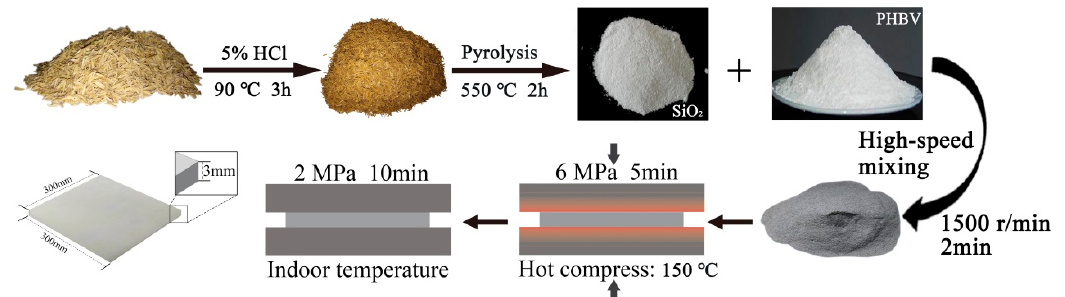
Figure 1 . Schematic illustration of RHNS/PHBV composites fabrication. Figure 1. Schematic illustration of RHNS/PHBV composites